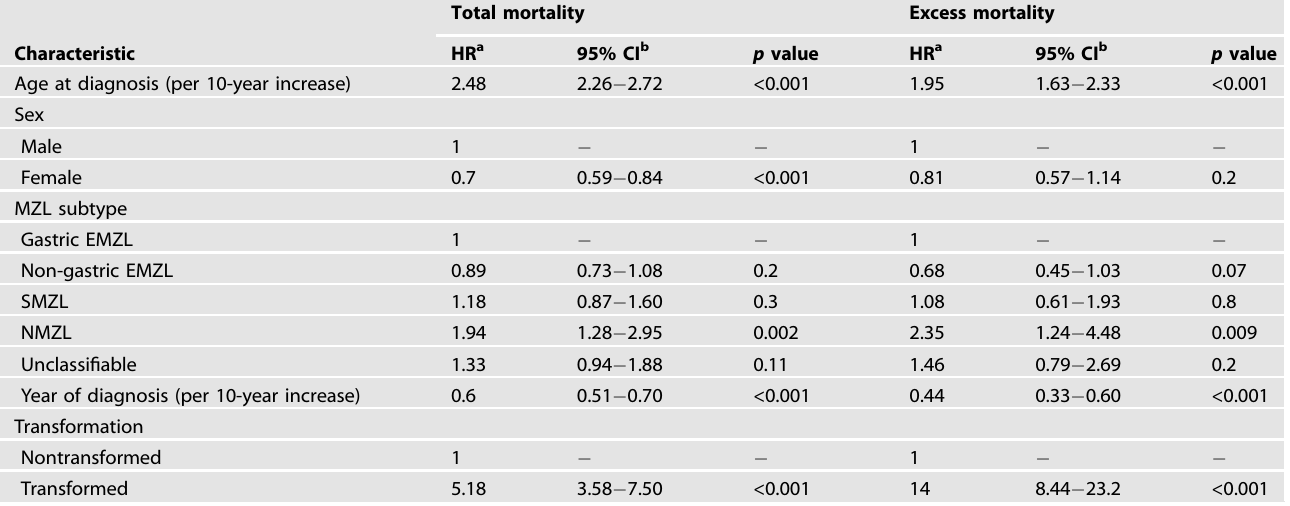
Table 3. Hazard ratios for total and excess mortality in patients with marginal zone lymphoma. Total mortality Excess mortality Characteristic HR